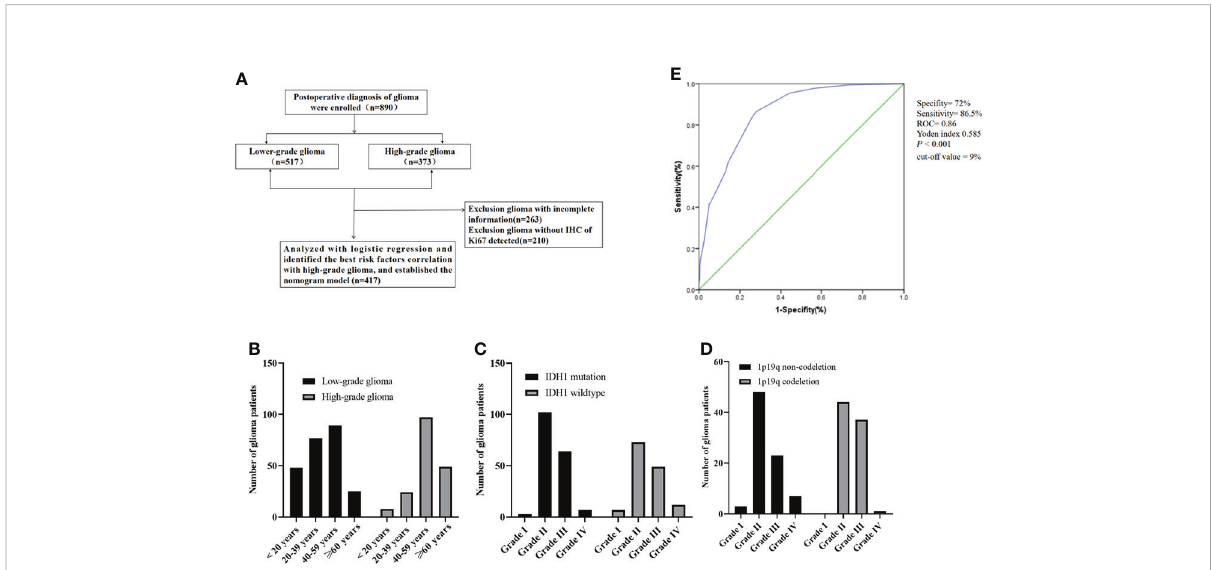
FIGURE 1 (A) Consort diagram, enrollment, and outcome; (B) the age distribution of patients with glioma; (C) IDH1 mutation status of patients with glioma; (D) the number of glioma patients with 1p19q codeletion status; (E) the Ki-67 curve of cut-off value (according to the LGG and HGG). ROC, Receiver operating characteristic; IDH1, Isocitrate dehydrogenase